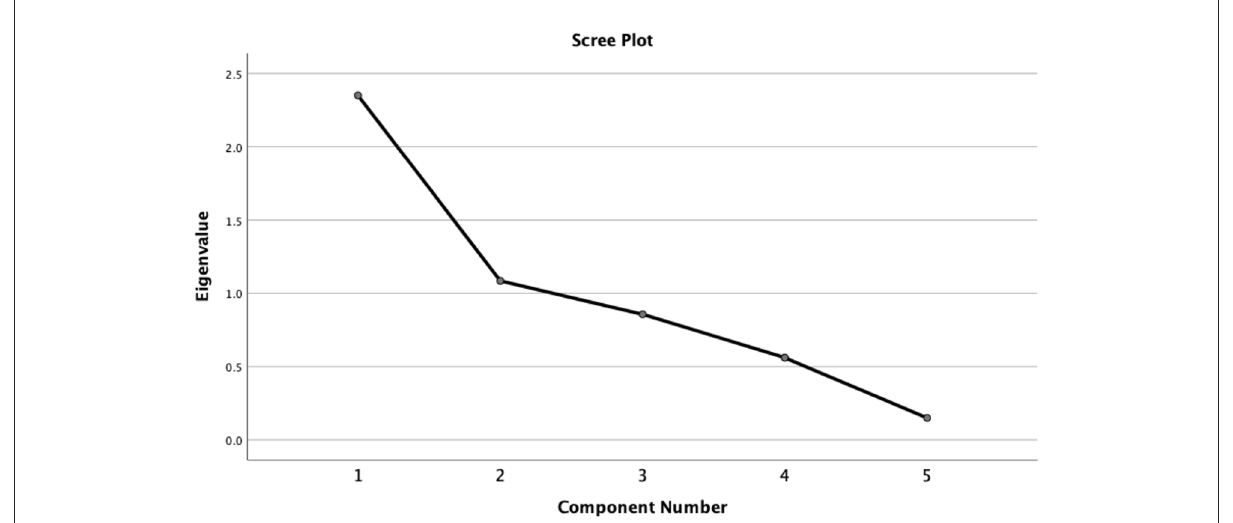
FIGURE3 Scree plot for principal component analysis of fluency and vocabulary measures.